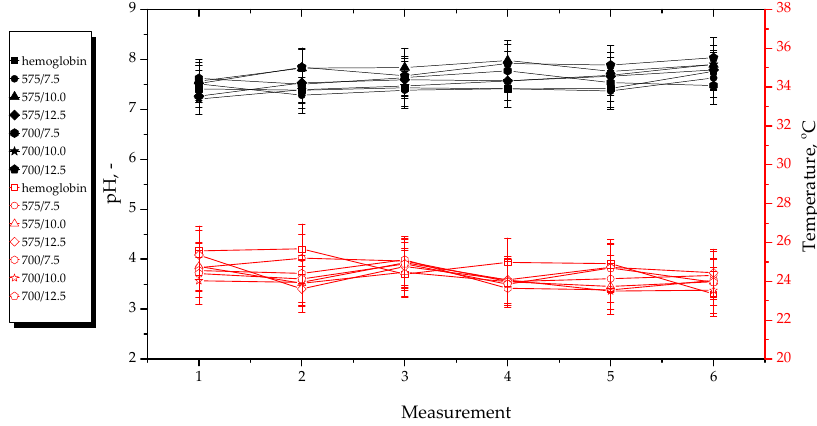
Figure 14. pH and temperature measurements during incubation of hydrogels in hemoglobin.